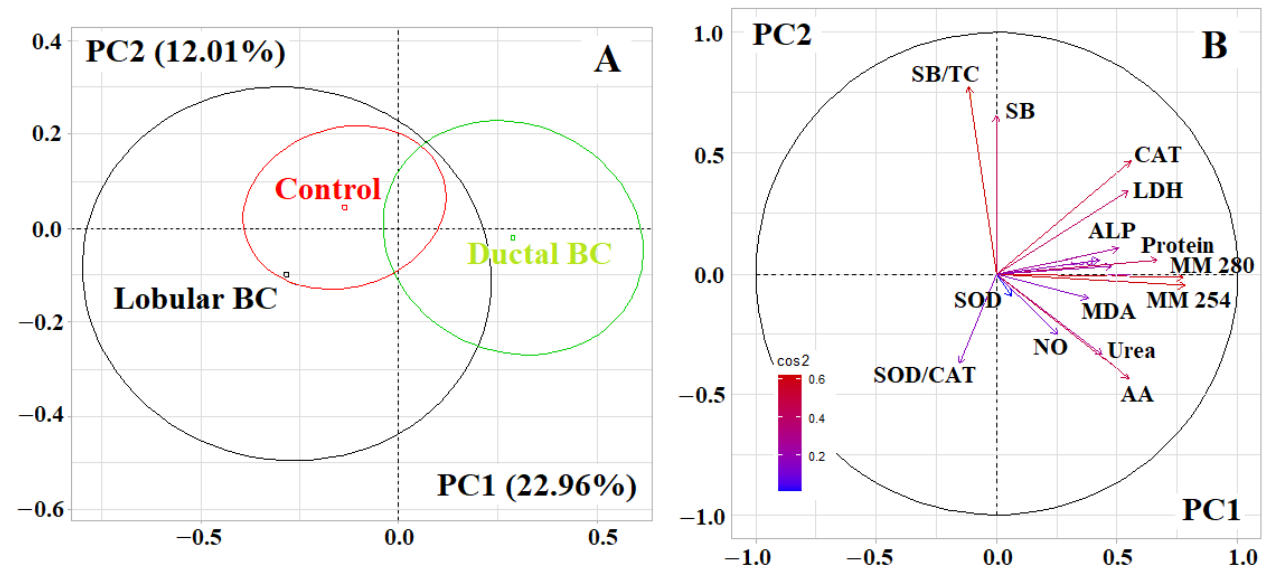
Figure 3. ( A )—Individuals factor map (PCA); ( B )—Variables factor map. UA—uric acid, LDH— Figure 3. ( A ) — Individuals factor map (PCA); ( B ) — Variables factor map. UA — uric acid, LDH — lactate dehydrogenase, CAT—catalase, ALP—alkali phosphatase, MDA—malondialdehyde, GGT— lactate dehydrogenase, CAT — catalase, ALP — alkali phosphatase, MDA — malondialdehyde, gamma glutamyltransferase, AA— α -Aminoacids, SB—Schiff Bases, TC—triene conjugates, SOD— GGT — gamma glutamyltransferase, AA —α -Aminoacids, SB — Schiff Bases, TC — triene conjugates, superoxide dismutase, MM—middle molecules. SOD — superoxide dismutase, MM — middle molecules.